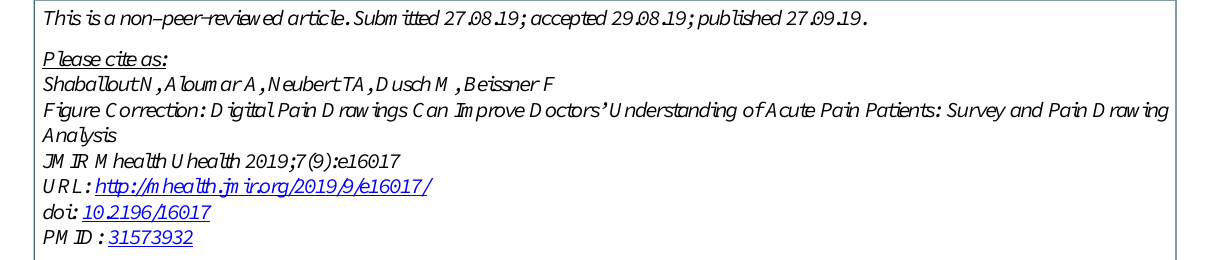
Figure Correction: Digital Pain Drawings Can Improve Doctors’ Understanding of Acute Pain Patients: Survey and Pain Drawing